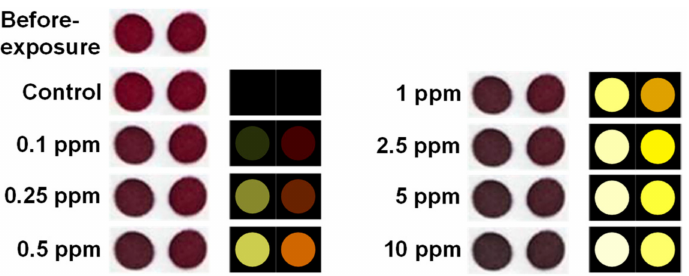
Figure 4. Images of sensors made from 150 ( left spot of each sensor strip image ) and 300 ◦ C ( right spot ) microspheres before and after the vapor exposure, and RGB color different profiles (right) that show colorimetric sensor responses to different concentrations of cyclohexanone plus a control (i.e., N 2 ) for 2 min. Each pattern was averaged out of three trials. For display purposes, each RGB profile was narrowed down from 8 bit (0–255) to 3 bit (3–10) color